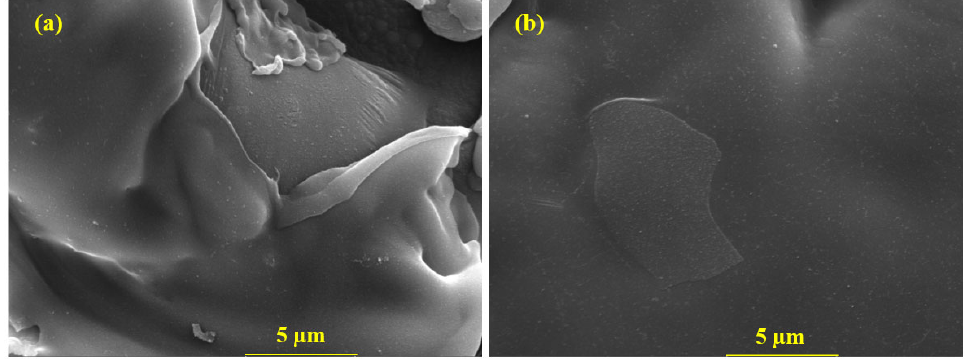
Figure 2. SEM of ( a ) Al and ( b ) Al-5 Mg coatings deposited by plasma arc thermal spray process at 10,000×.